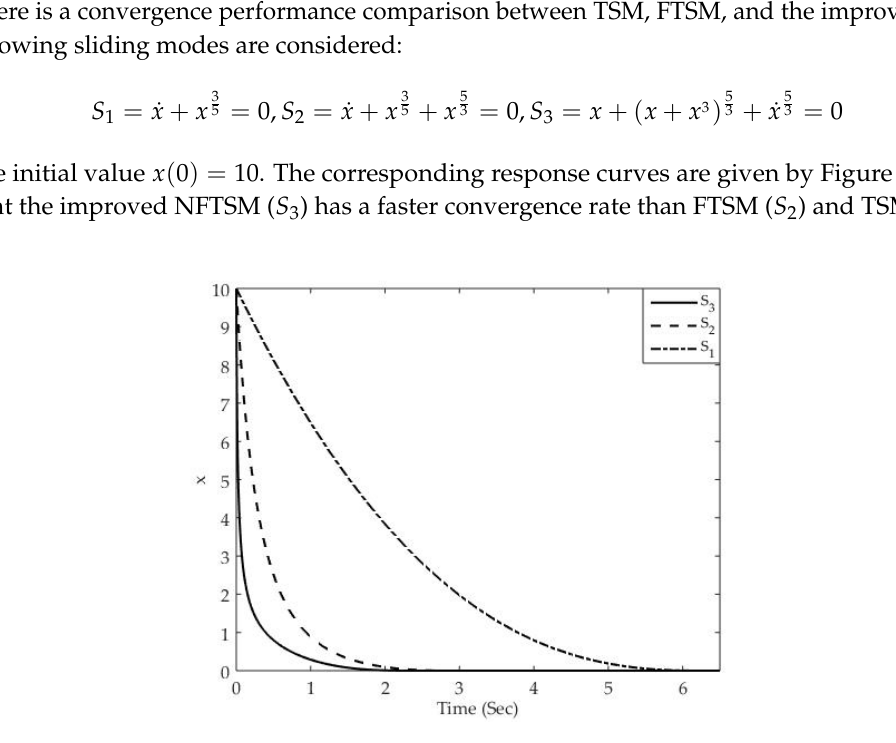
Figure 5. The comparison of convergence performance between NFTSM, FTSM, and